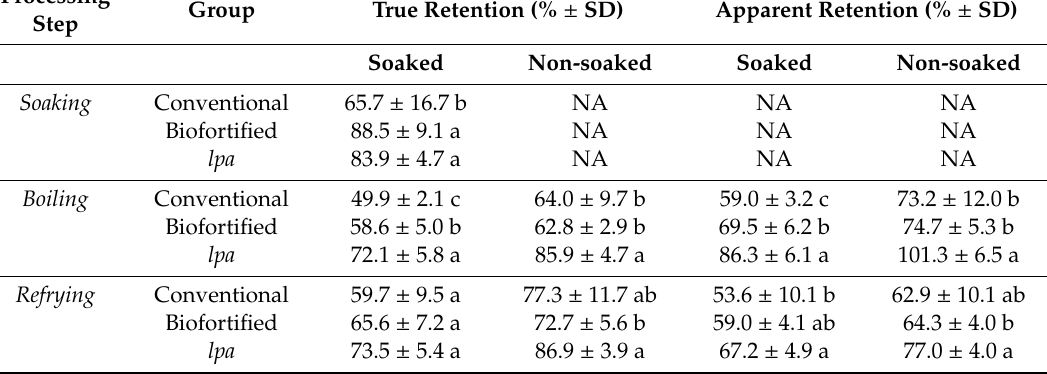
Table 6. True and apparent retention (% ± SD) for phytic acid of three groups of beans after five di ff erent processing